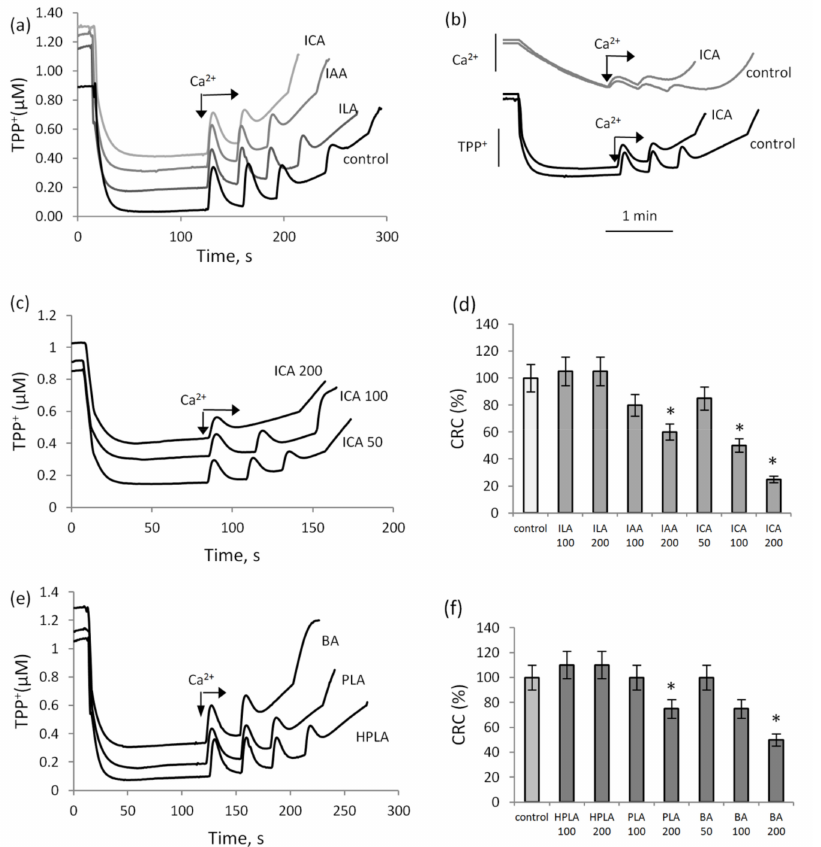
Figure 1. Influence of indolic and phenolic acids on MPTP opening induced by calcium ions. MPTP opening in the course of successive additions of 25 µ M CaCl 2 in the presence of indolic acids at a concentration of 100 µ M, determined by a drop in the membrane potential ( a ) and by Ca 2+ release ( b ) in the control and in the presence of indole carboxylic acid (ICA, 100 µ M). A decrease in the calcium retention capacity (CRC) with an increase in ICA concentration from 50 to 200 µ M ( c ) and changes in the CRC at different concentrations of other indolic acids ( d ). MPTP opening measured by the membrane potential changes in the course of successive additions of 25 µ M CaCl 2 in the presence of phenolic acids at a concentration of 100 µ M ( e ) and changes in the CRC at different concentrations of phenolic acids ( f ). Asterisk (*) indicates values that differ significantly from the control values ( p <